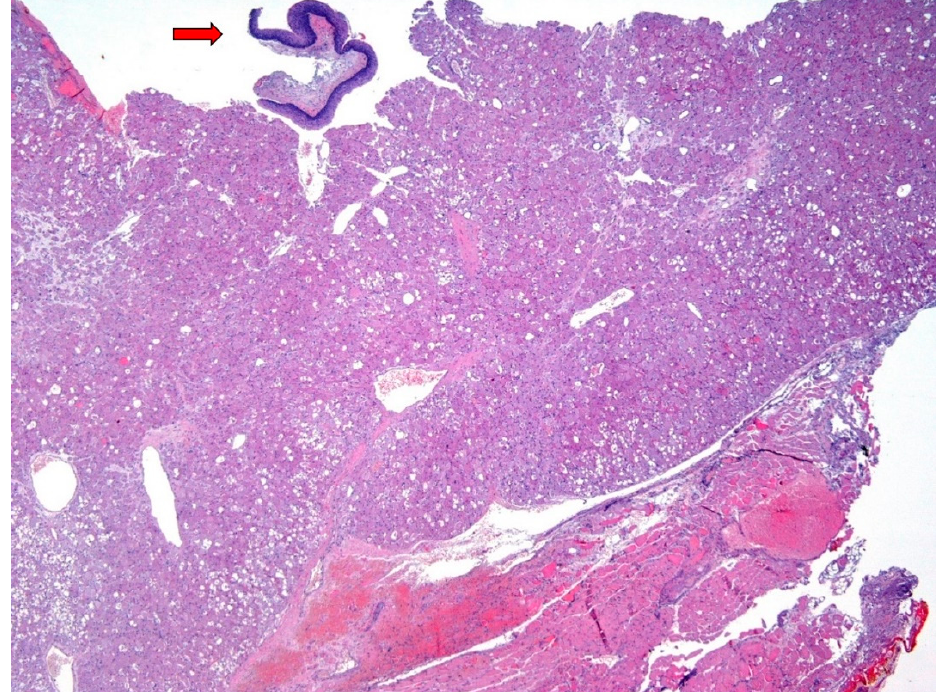
Figure 2. An excisional biopsy was performed. On gross exam, the lesion had a hemorrhagic appearance. Histological examination revealed a highly cellular tumor (upper part of the Figure), involving the subepithelial connective tissue, with extensive superficial de-epithelization (arrow: residual squamous epithelium of the vocal cord). The lesion was unencapsulated and mainly well- delimited from the underlying striated muscle layer (lower part of the Figure), with pushing growth borders; however, the partial fragmentation of the material did not allow a complete definition of the tumor growth front. The surgical margins were involved, while biopsies of the bilateral false vocal cords were unaffected (Hematoxylin and Eosin, 4×; previously unpublished, original photo).